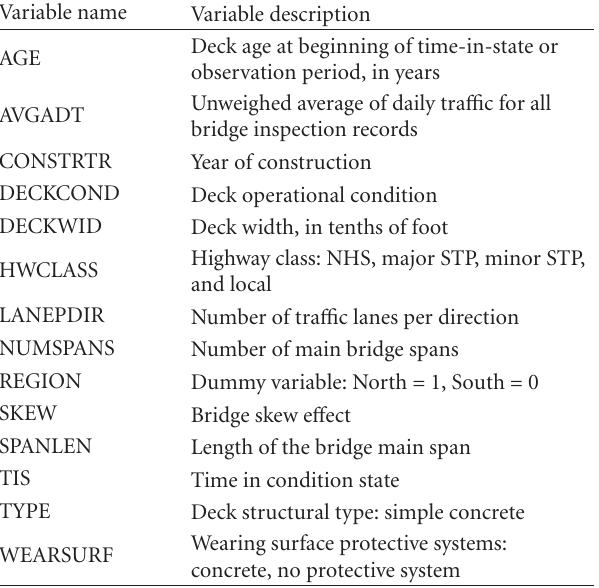
Table 3: Explanatory variables used in the BRP method